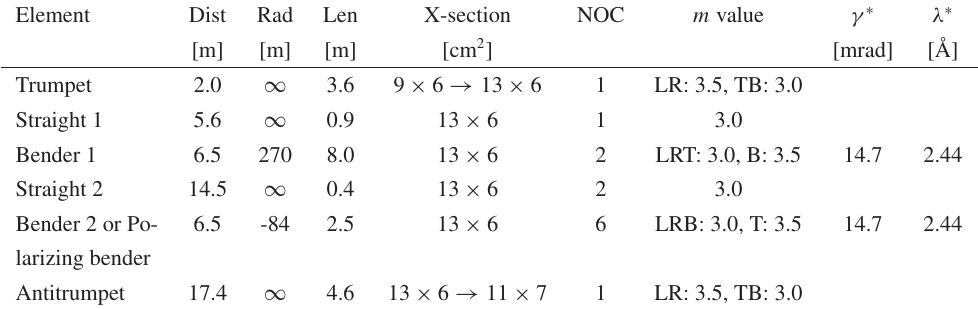
Table 1. Key parameters of the guide components. Dist: Distance from the moderator to the start of the element. Rad: Radius of curvature. Negative means bend downwards. Len: Length of element. X-section: Width × Height. Trumpet and antitrumpet change the cross-section linearly from start to end (indicated by arrow). NOC: Number of channels in vertical direction. Channels are separated by 1 mm thick plates. m value: Supermirror coating for all sides or separately for Left, Right, Top, and Bottom seen from the moderator. γ ∗ and λ ∗ : Characteristic parameters of curved